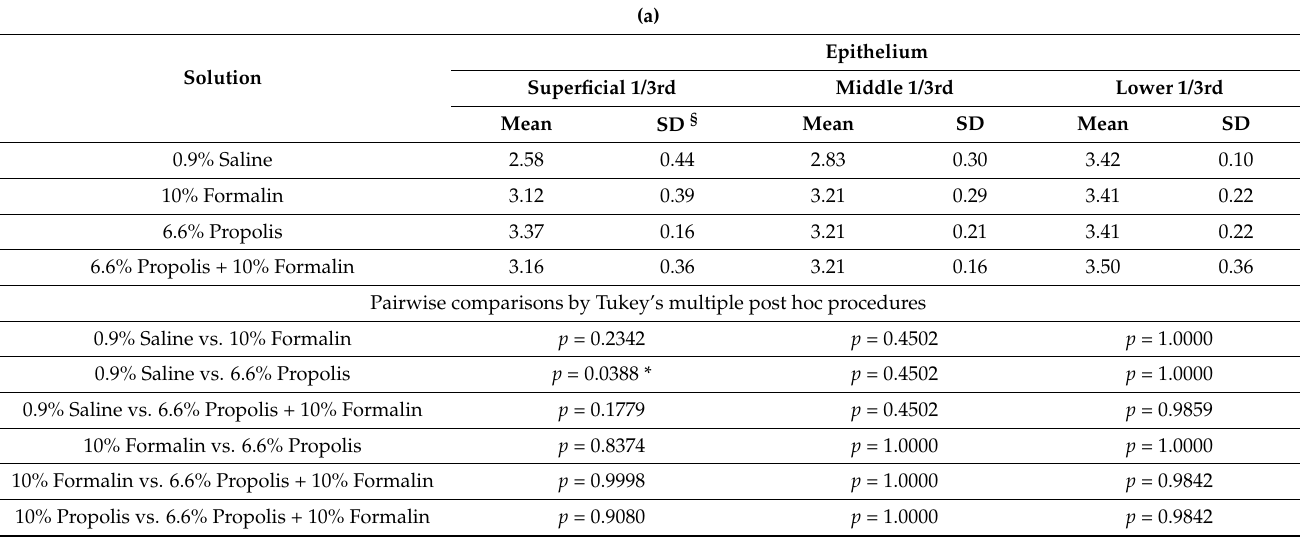
Table 6. (a) Comparison of fixative ability of different solutions in different microscopic structures (epithelium). (b) Comparison of fixative ability of different solutions in different microscopic structures (basement membrane, nerve bundles, and fibrous tissue). (c) Comparison of fixative ability of different solutions in different microscopic structures (blood vessels, skeletal muscles, and adipose